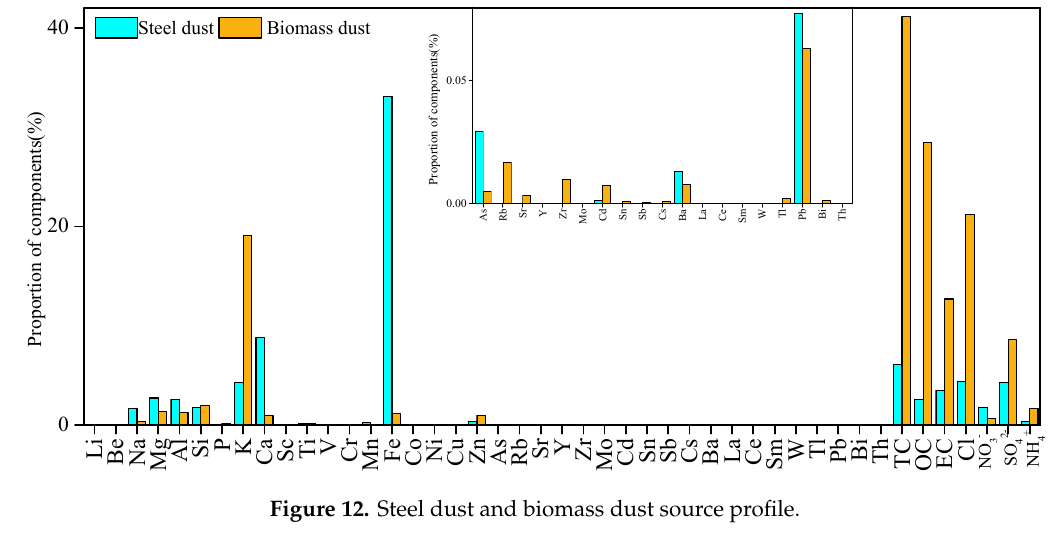
Figure 12. Steel dust and biomass dust source profile.